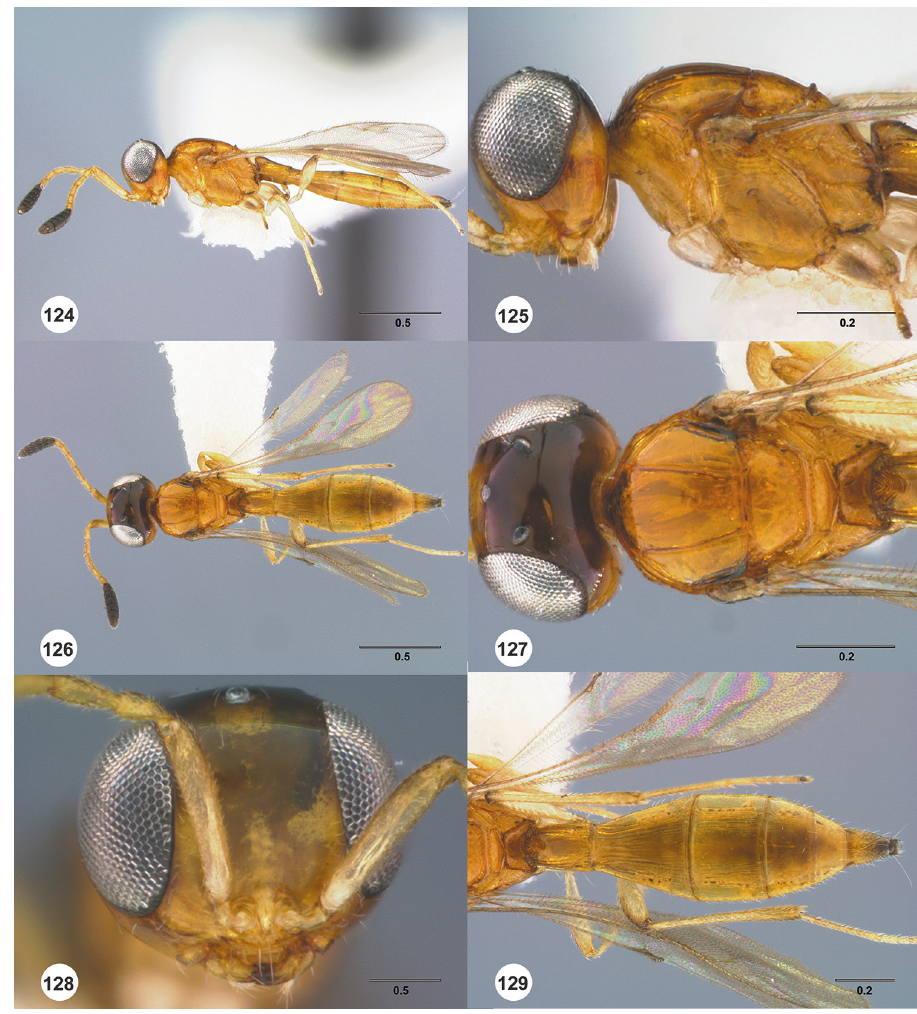
Figures 124–129. Calliscelio glaber sp. n., female, holotype (OSUC 458136). 124 Lateral habi- tus 125 Head and mesosoma, lateral view 126 Dorsal habitus 127 Head and mesosoma, dorsal view 128 Head, anterior view 129 Metasoma, dorsal view. Scale bars in millimeters.